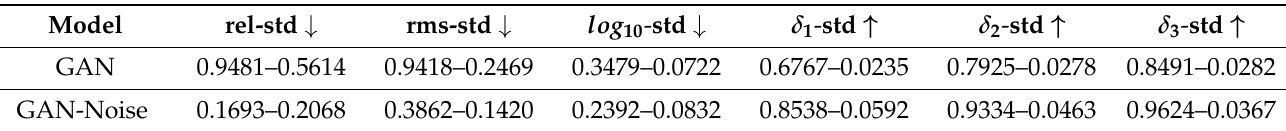
Table 3. Performance of the quantitative metrics in our approach and the standard deviation of 50 samples. ↓ , lower is better; ↑ , higher is better.